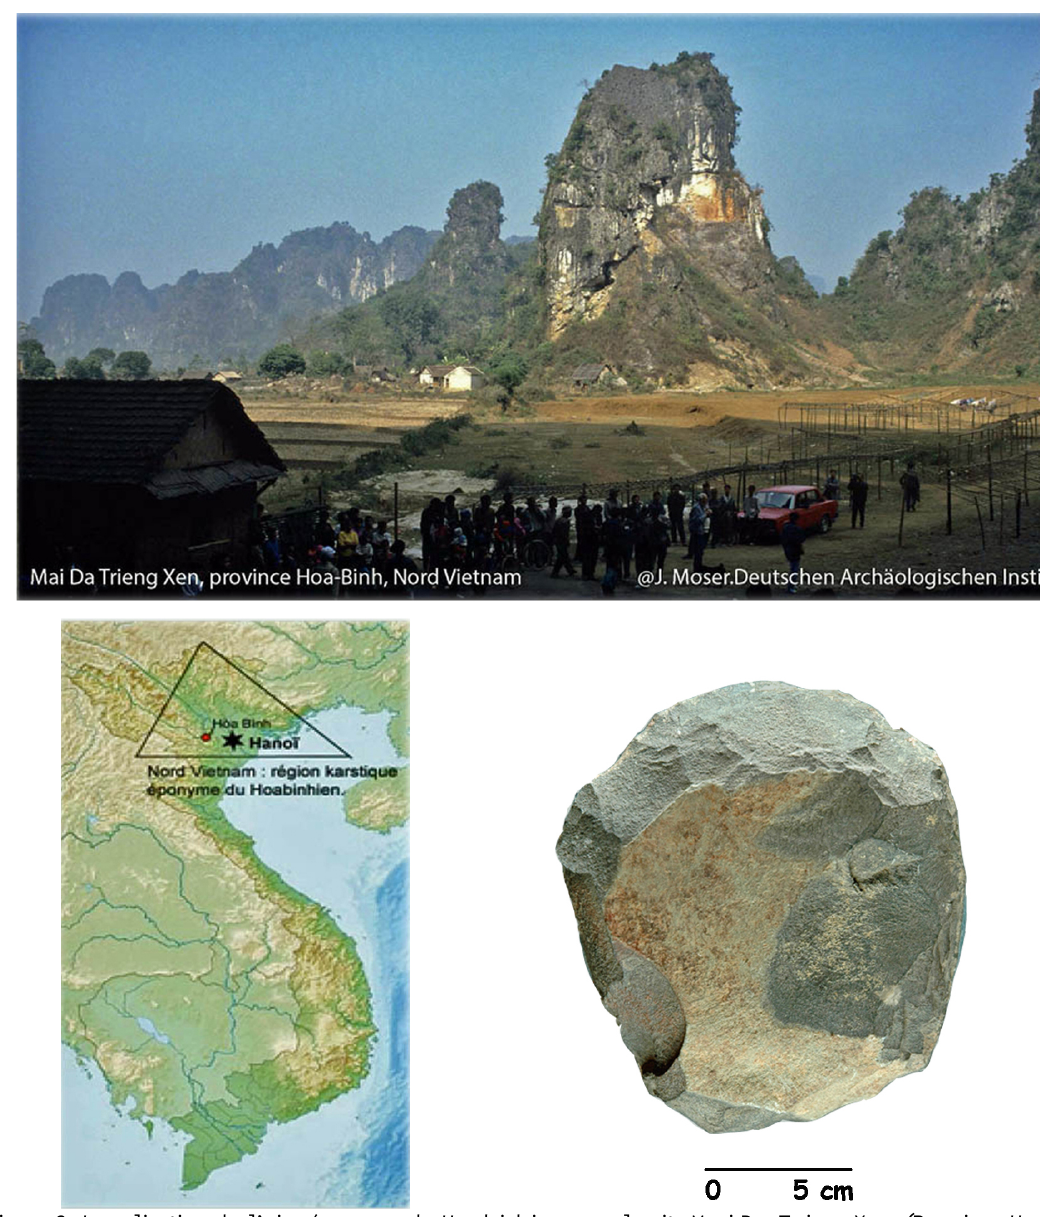
Figure 3. Localisation de l’aire éponyme du Hoabinhien avec le site Mai Da Trieng Xen (Province Hoa-Binh, Nord Vietnam) (photo d’après J. Moser). Figure 3. Localisation of the eponymous Hoabinhian area with Mai Da Trieng Xen site (Hoa-Binh Province, North Vietnam) (photo after J.